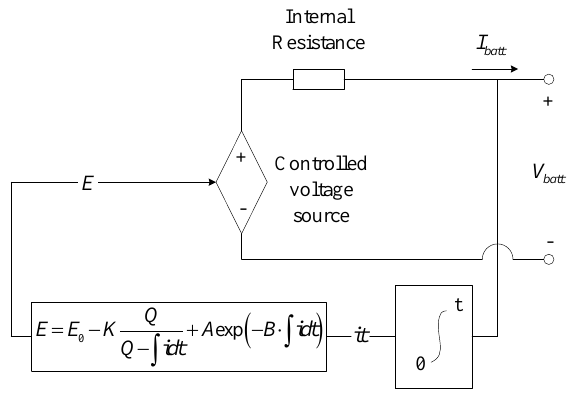
Figure 2. Non-linear battery model.